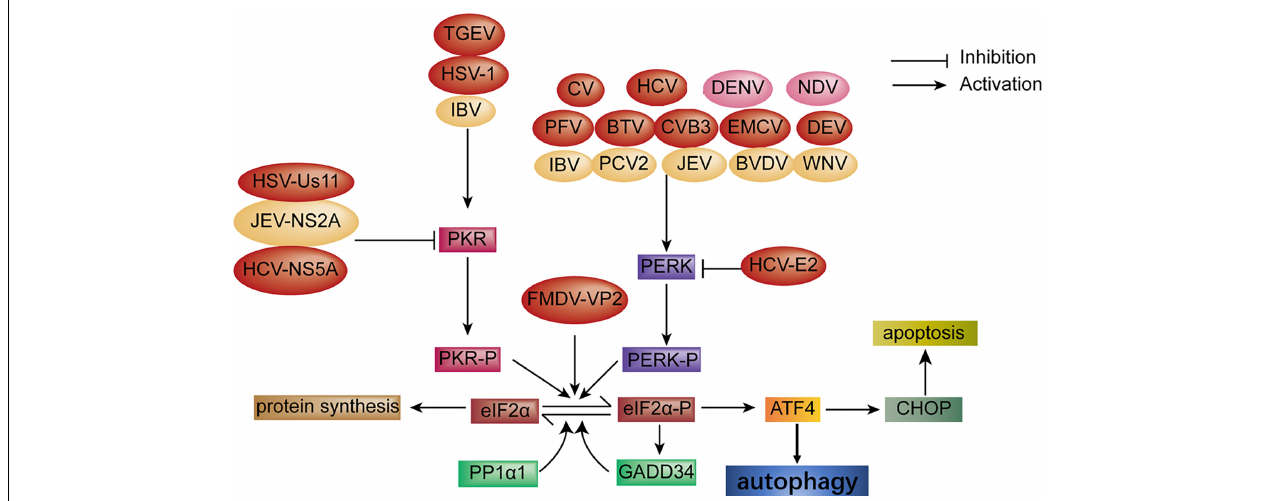
FIGURE 2 | Diagram of the activation of autophagy and apoptosis via the ISR signaling pathway during viral infection. Autophagy: Autophagy is activated through the PKR-eIF2 α pathway upon infection with transmissible gastroenteritis virus (TGEV) and HSV-1 infection; CV, HCV, PFV, BTV, CVB3, encephalomyocarditis virus (EMCV) and DEV infection, respectively, induces autophagy through the PERK-eIF2 α pathway. FMDV-VP2 induces autophagy through interaction with HSPB1 and activation of the eIF2 α -ATF4 pathway. In turn, HSV-Us11, HCV-NS5A, and HCV-E2 protein block autophagy (red color). Apoptosis: Apoptosis is induced via the PERK and PKR-eIF2 α pathway under infection with IBV, PCV2, BVDV, JEV, and WNV, respectively. Oppositely, the JEV-NS2A protein inhibits apoptosis (yellow color). In addition, autophagy and apoptosis simultaneously are induced through the PERK-eIF2 α pathway during DENV and NDV infection, respectively (pink